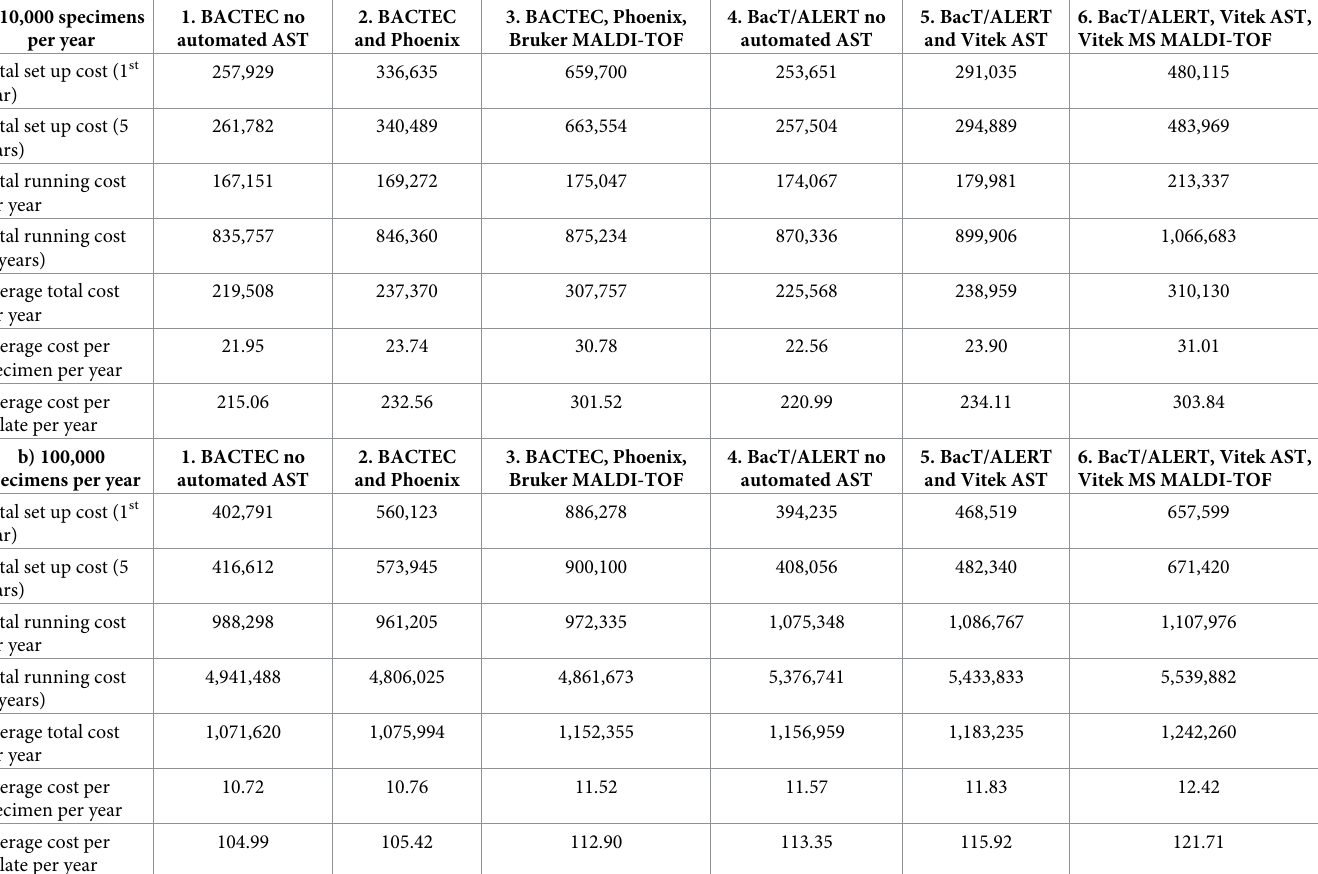
Table 2. Costs for setting up and running a laboratory in Southeast Asia (USD, 2020) at two capacity levels; a) 10,0000 specimens per year and b) 100,000 specimens per